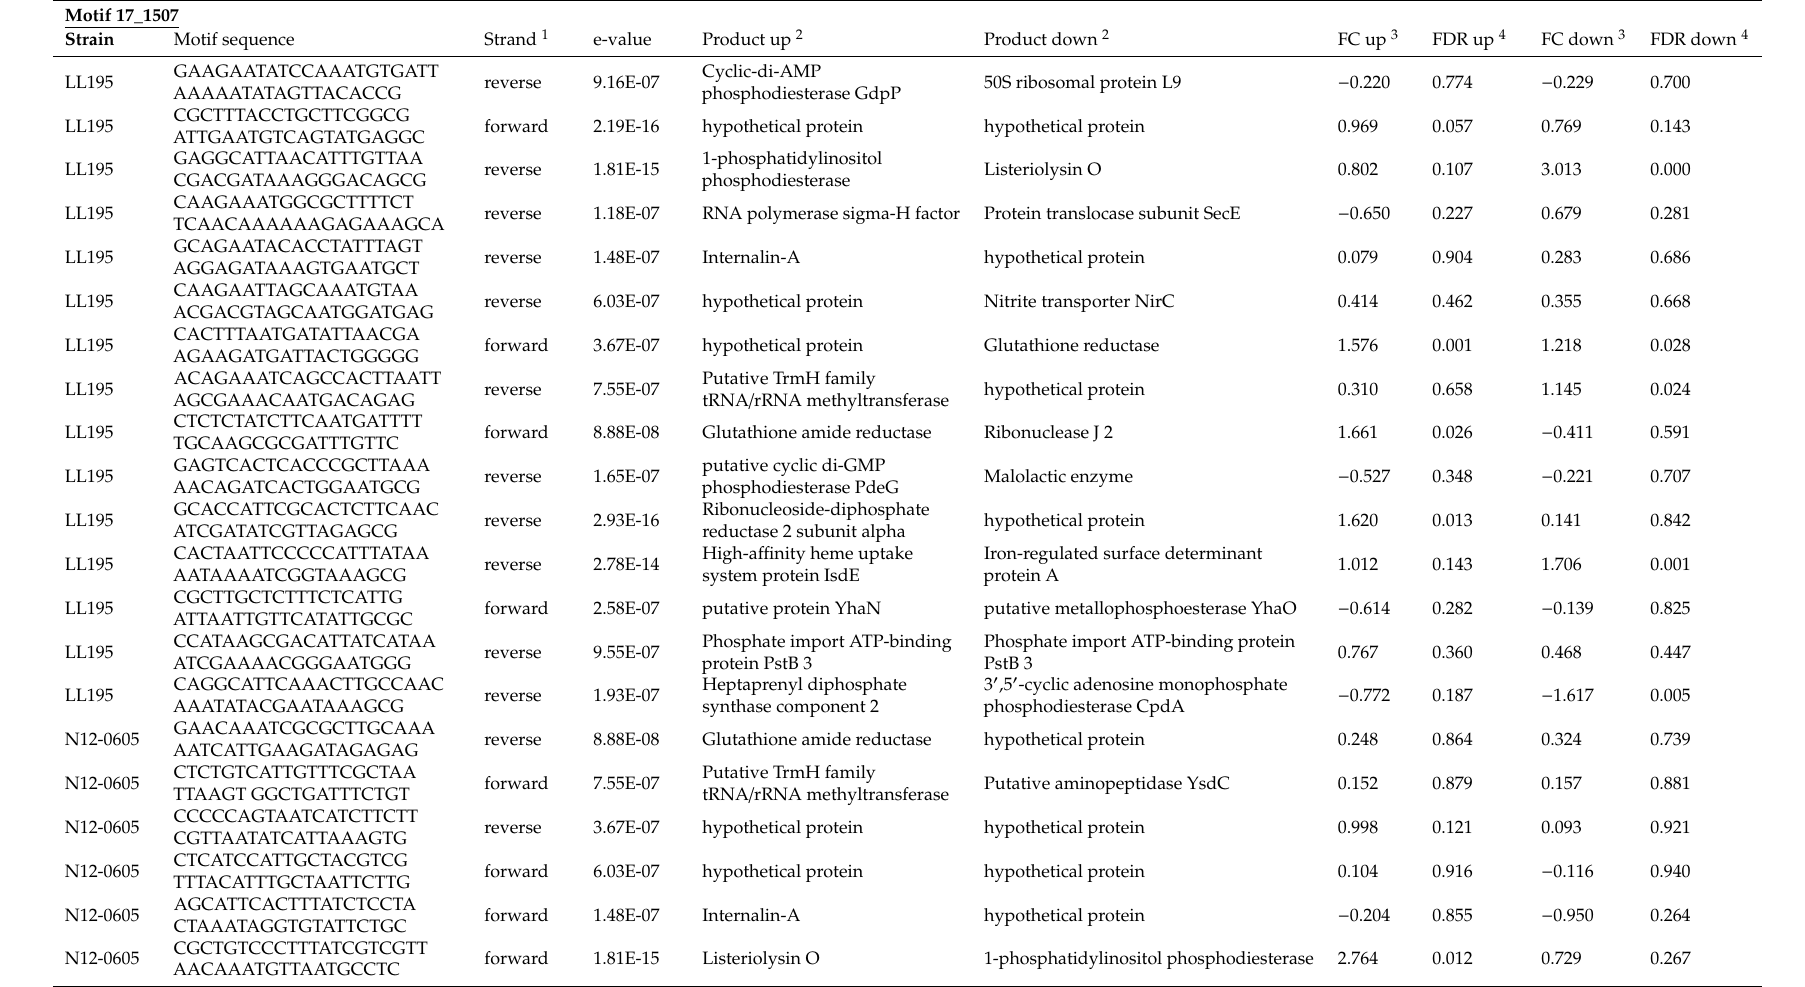
Table 1. Motifs identified within 150bp upstream of di ff erentially expressed